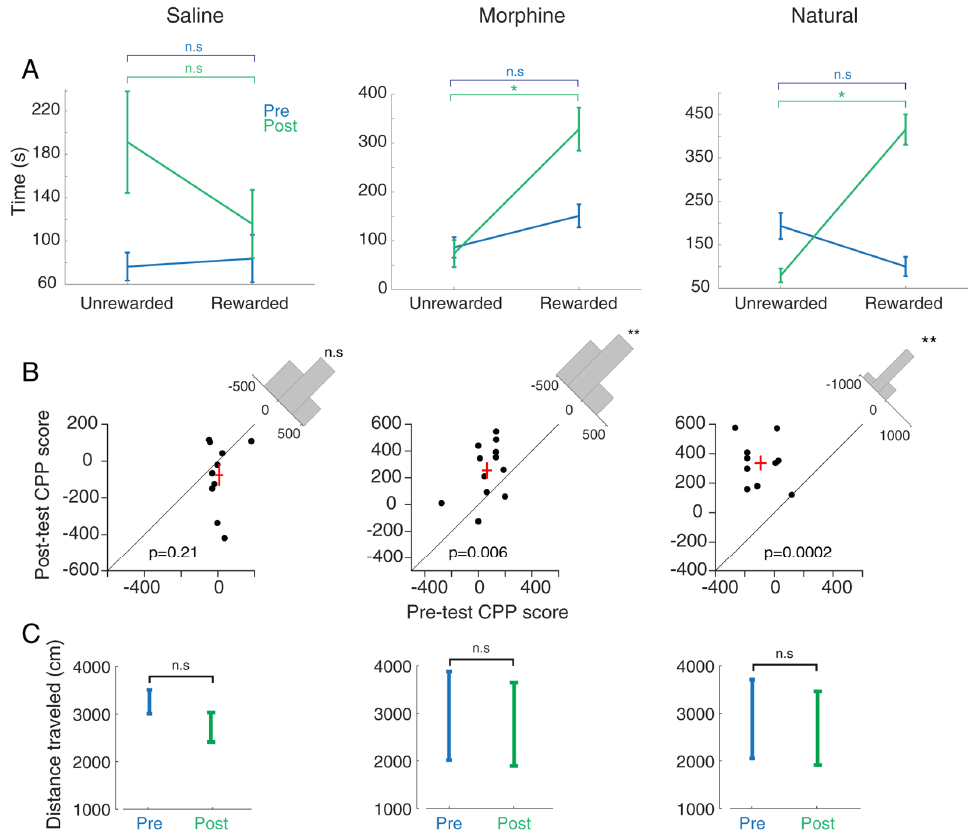
Figure 2. Behavioral data for each saline-CPP, morphine-CPP (as drug), and natural-CPP (food). ( A ) The time spent in rewarded compartment compared to unrewarded compartment during the pre-test (blue color) and post-test (green color). ( B ) Comparing the CPP score of the post-test with the pre-test. Black dots show the numbers of rats in each group; Red cross indicates the average of CPP score ( C ) Comparing the distance traveled between pre-test and post-test. Morphine injection (5 mg/kg, s.c.) induced CPP, and injected rats had a greater tendency to stay in the rewarded (morphine-paired) compartment vs. unrewarded (non-drug) compartment during post-test (( A ); middle panel). Conditioning by biscuit (natural reward) induced CPP; rats received biscuit during conditioning days had a greater tendency to stay in the rewarded (food-paired) compartment vs. unrewarded (no food) compartment in the post-test session (( A ); right panel). Rats that received morphine had a higher CPP score in the post-test compared to pre-test (( B ); middle panel). Rats that received biscuit as a natural reward showed a higher CPP score in the post-test than the pre-test (( B ); right panel). * p < 0.05 as compared with the unrewarded compartment. ** p < 0.01 as compared with the pre-test session. n.s. as not